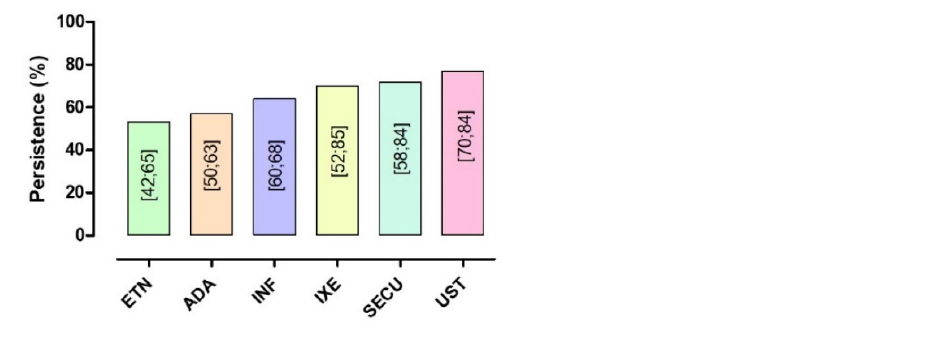
Figure 7. Percentage of persistent patients according to biological drugs. Confidence intervals (95%) are reported within vertical bars.